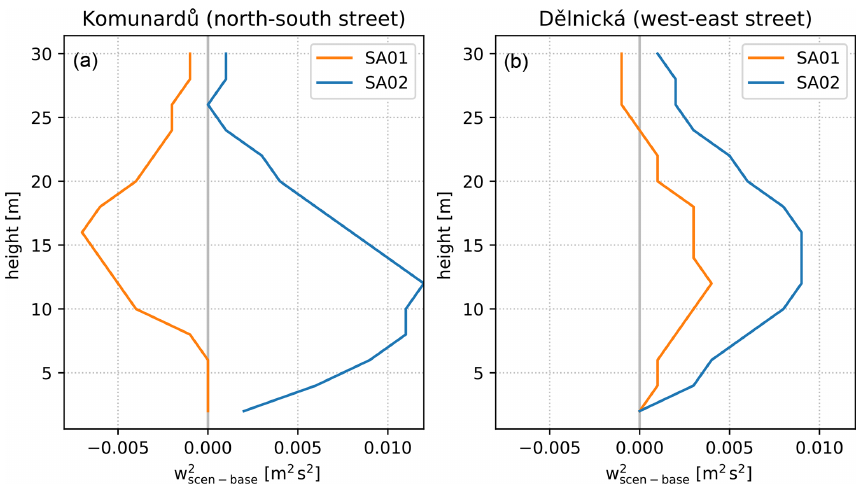
Figure 5. Daily average profiles of w 2 (plotted as the difference: scenario − base case) averaged over the two main streets: the north–south- oriented Komunard˚u (a) and the west–east-oriented D ˇ elnická (b) .